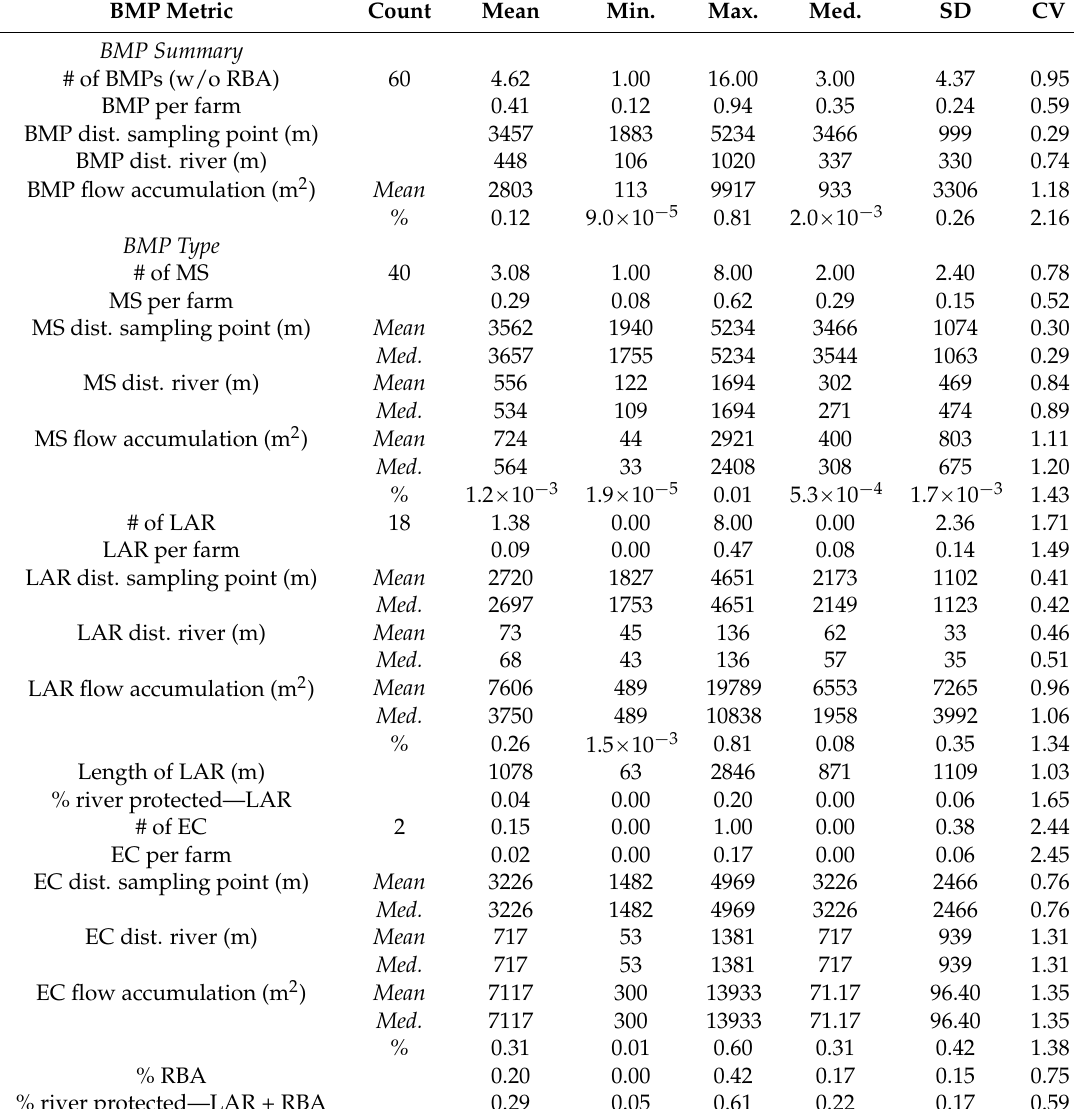
Table 4. Descriptive statistics of BMP metrics for the 13 sampled catchments. BMP descriptions are separated based on metric grouping ( i.e. , BMP summary or BMP